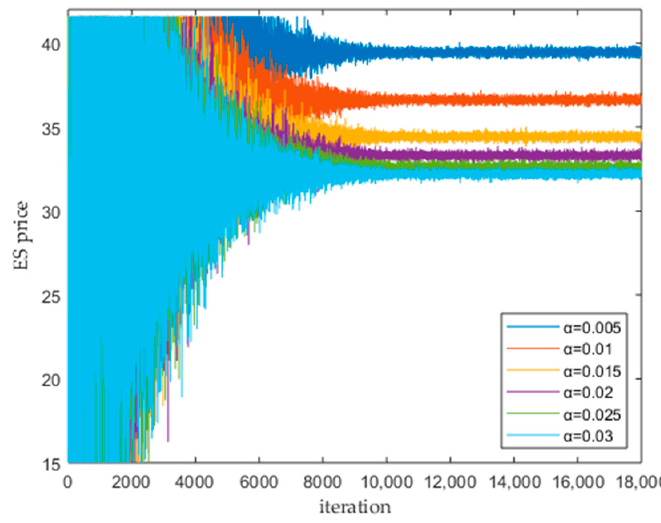
Figure 7. The ES price for di ff erent elasticity prosumers.